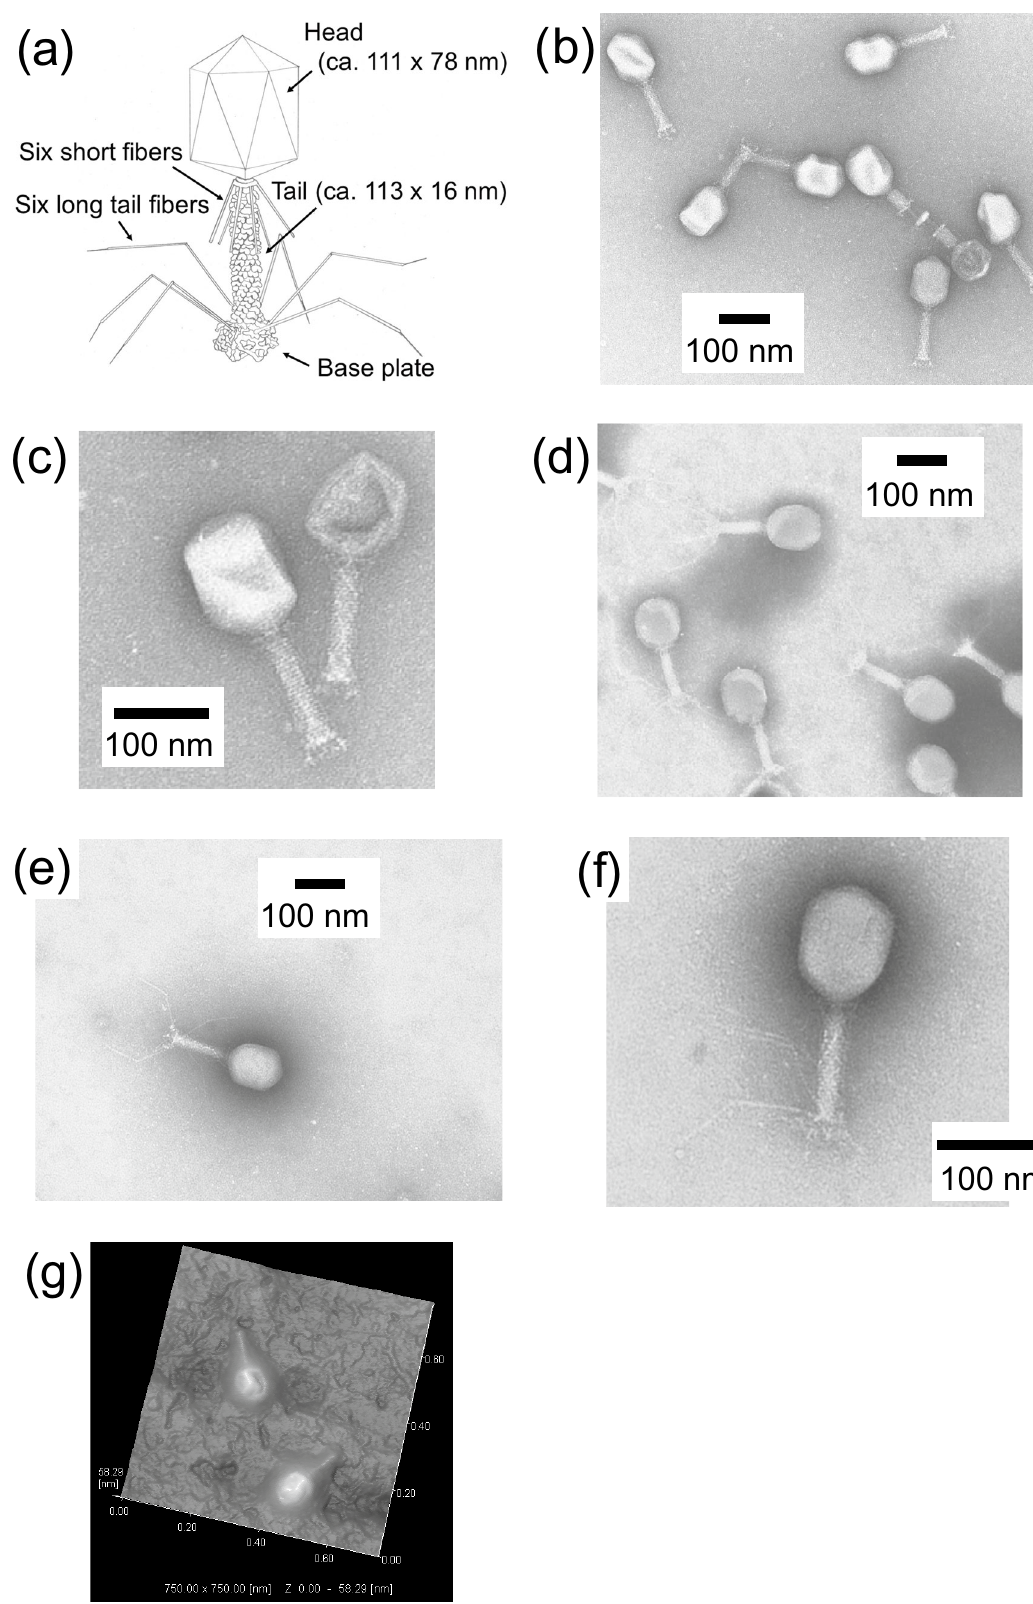
Figure 3. ( a ) Morphology of T4 phage. ( b – e ) Transmission electron microscopy (TEM) images of T4 phages using negative staining reagents ( b , c ) uranyl acetate, ( d ) neutralized Keggin-type PTA (H 3 [PW 12 O 40 ]–KOH), and ( e , f ) potassium salt Na-encapsulated Preyssler-type phosphotungstate (K 14 [P 5 W 30 O 110 Na(H 2 O)]). ( g ) Atomic force microscopy (AFM) image of the TEM